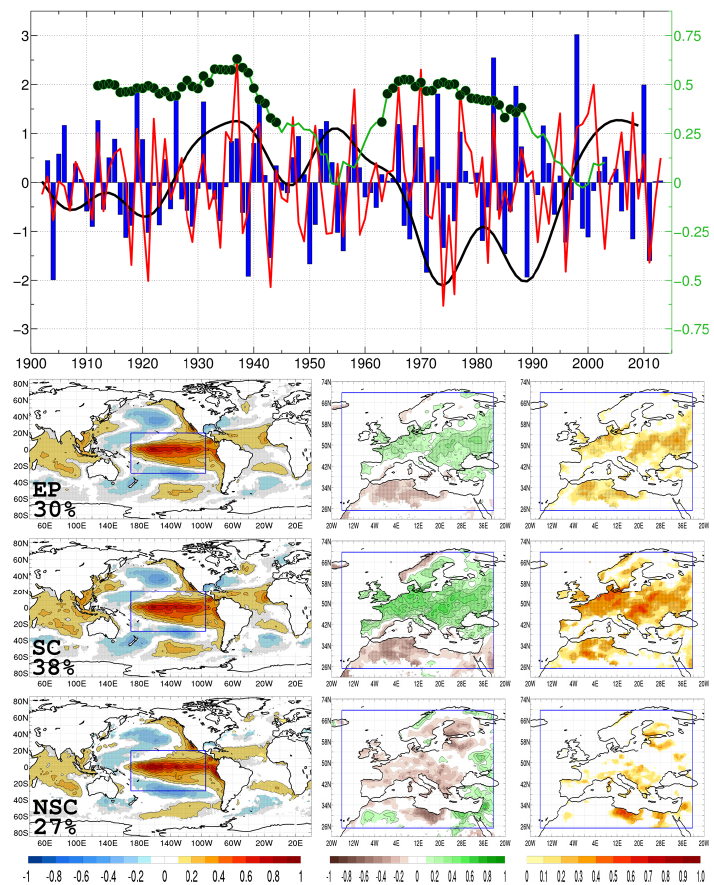
Figure 4. ( Top Panel ) Expansion coefficients of the leading MCA mode calculated between the anomalies of tropical Pacific SST (blue bars, left axis) and the anomalous Euro-Mediterranean rainfall (red line, left axis) in FMA. Superimposed, the 21-year centered moving correlation windows (green line, right axis) and significant correlation (black filled circles, right axis) between both expansion coefficients. The black curve corresponds to the AMO index; ( Bottom Panels ) ( First ) Regression maps of the SST expansion coefficient of the leading MCA mode onto the SST (left) and rainfall (center); Correlation maps (right) between the cross validated hindcast of rainfall performed only with the leading MCA mode. The whole time period is used for the analysis. ( Second ) As (first) but using the years corresponding to the center of the significant correlation windows (green dots in the green curve). ( Third ) As (first) and (second) but using the years corresponding to the center of the non-significant correlation windows. The percentage of squared covariance fraction is indicated in the left bottom corner of the figure.